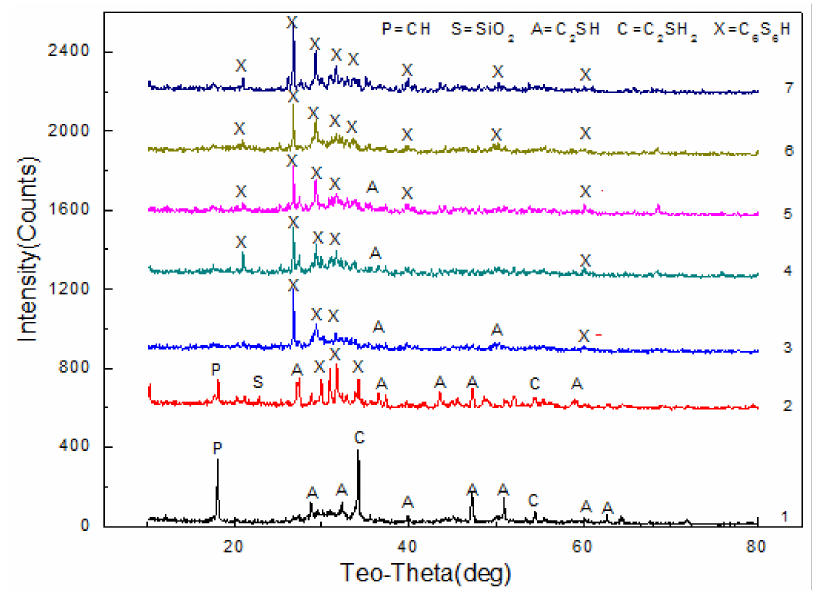
Figure 7. Phase analysis.